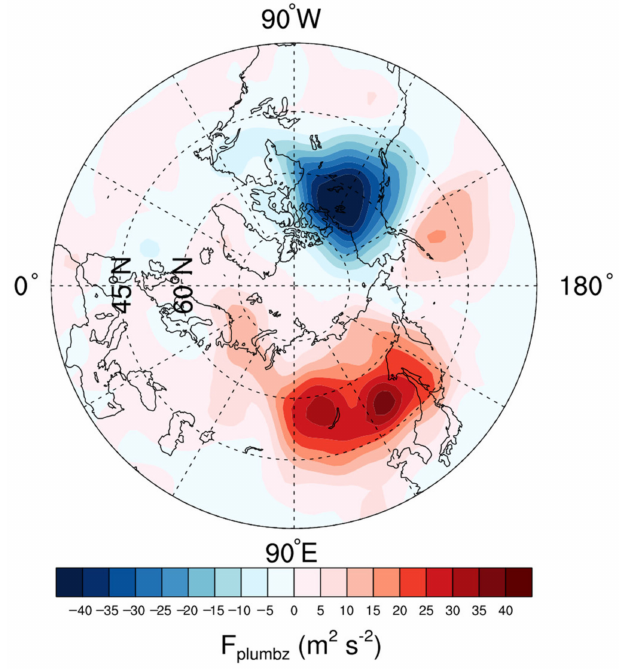
Figure 14. Composite of 10–60-day filtered vertical component of Plumb wave activity flux anomalies (unit: m 2 s − 2 ) along 30 ◦ –90 ◦ N at 100 hPa, 15 days before the onset of 2018 SSW